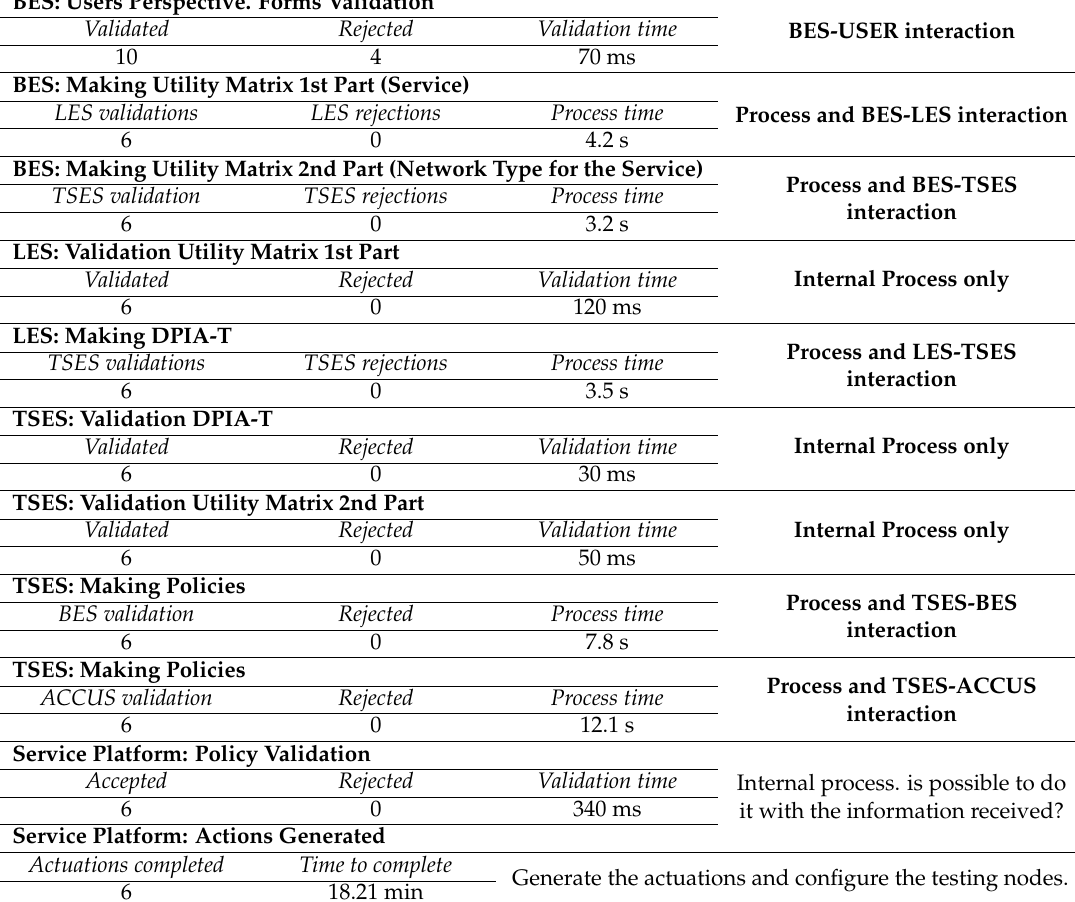
Table 12. System parts